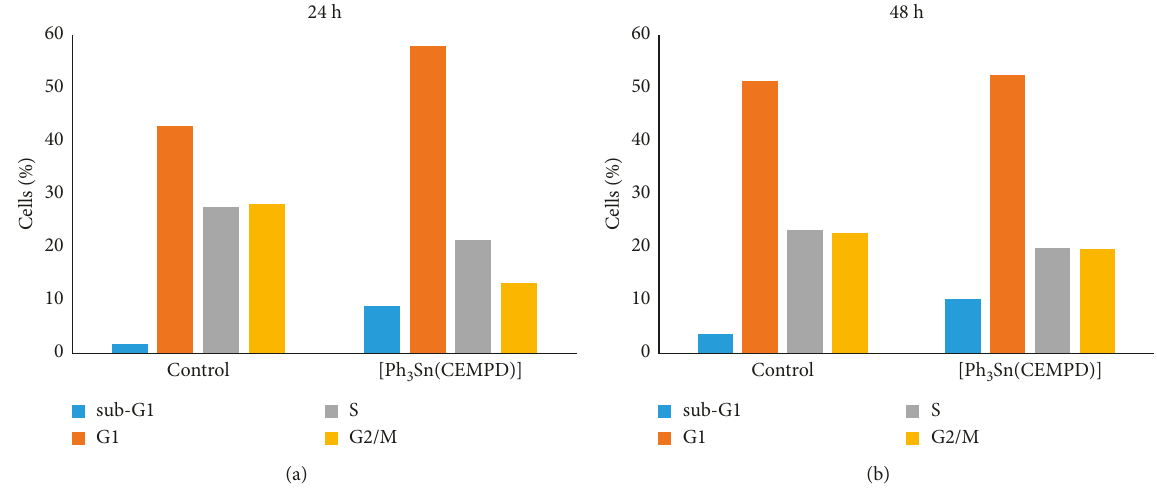
Figure 3: Effect of [Ph